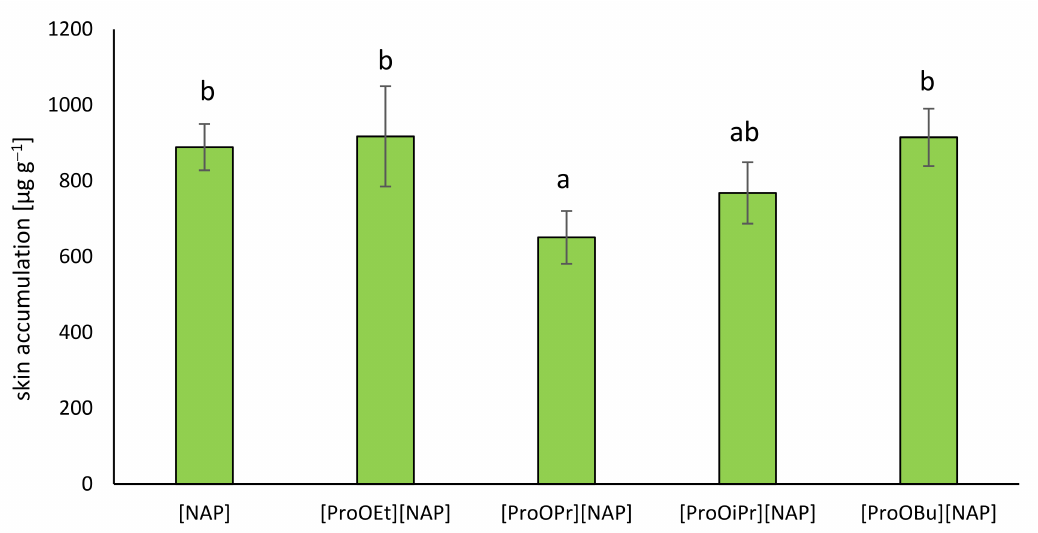
Figure 13. Accumulation in the skin of naproxen and its derivatives during the 24 h penetration; different letters indicate significant differences between the tested compounds; (the letter “a” stands for compounds accumulating in the smallest amount in the skin, while the letter “b”—compounds accumulating in the greatest amount in the skin); α = 0.05 (mean ± SD, n = 3). Statistically significant difference was estimated using the ANOVA